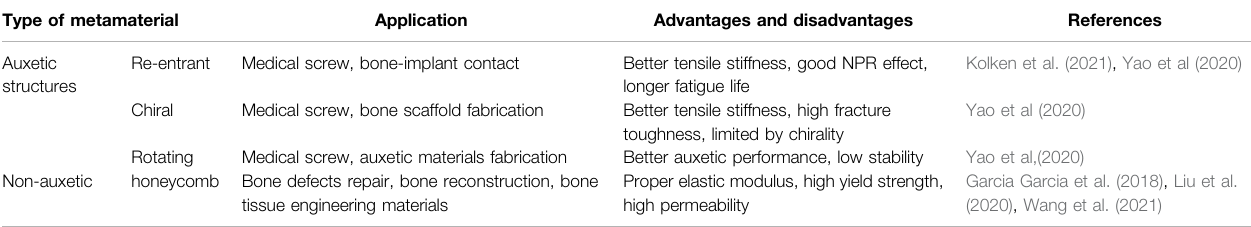
TABLE 3 | Summary of the metamaterials and their applications in bone